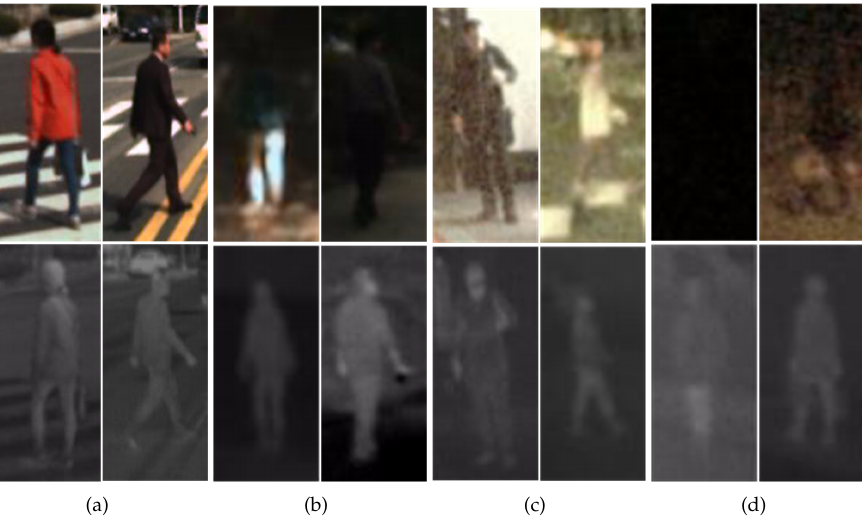
Figure 1. Examples of multispectral pedestrian detection images from KAIST. The first and second rows are color and thermal images, respectively. Panels ( a , b ) were captured in good and weak conditions in daytime traffic scenes. Panels ( c , d ) were captured under good and weak conditions in nighttime traffic